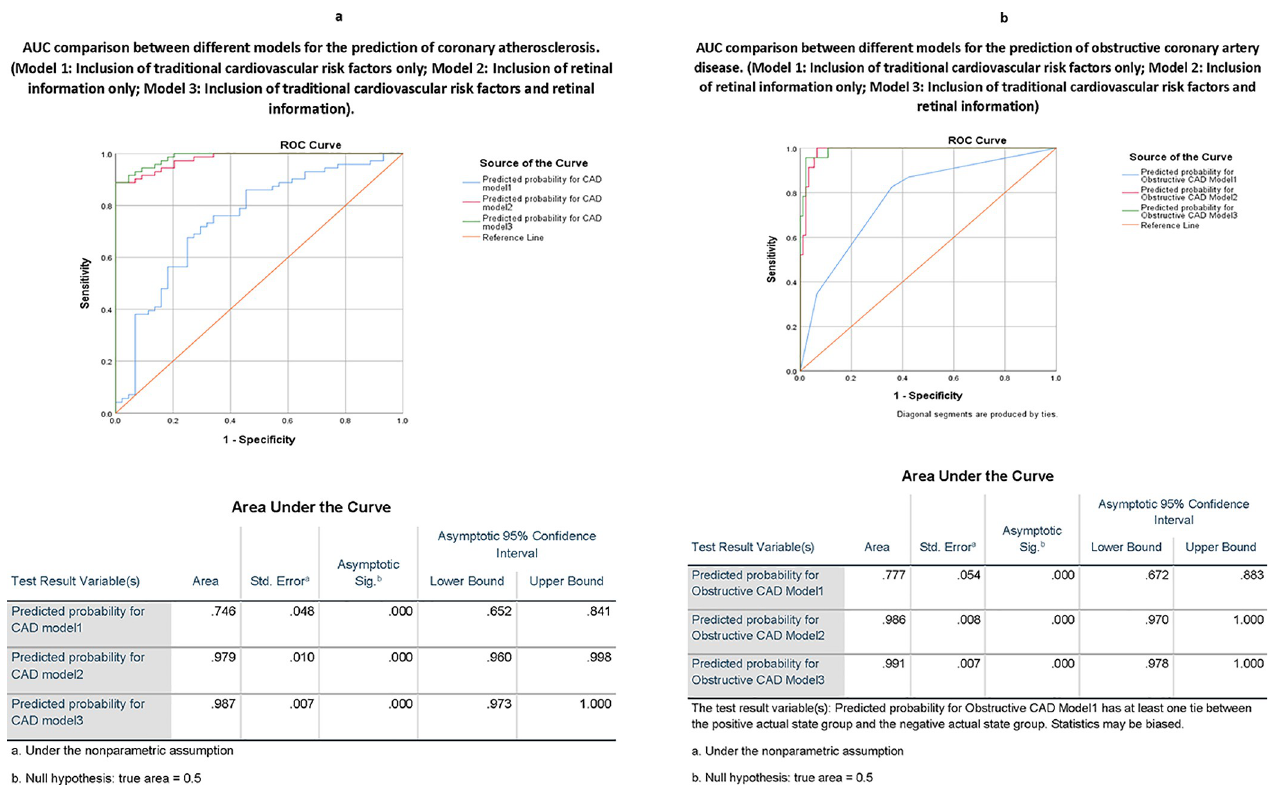
Fig 2. a. AUC comparison between different models for the prediction of coronary atherosclerosis. (Model 1: Inclusion of traditional cardiovascular risk factors only; Model 2: Inclusion of retinal information only; Model 3: Inclusion of traditional cardiovascular risk factors and retinal information). b. AUC comparison between different models for the prediction of obstructive coronary artery disease. (Model 1: Inclusion of traditional cardiovascular risk factors only; Model 2: Inclusion of retinal information only; Model 3: Inclusion of traditional cardiovascular risk factors and retinal information).